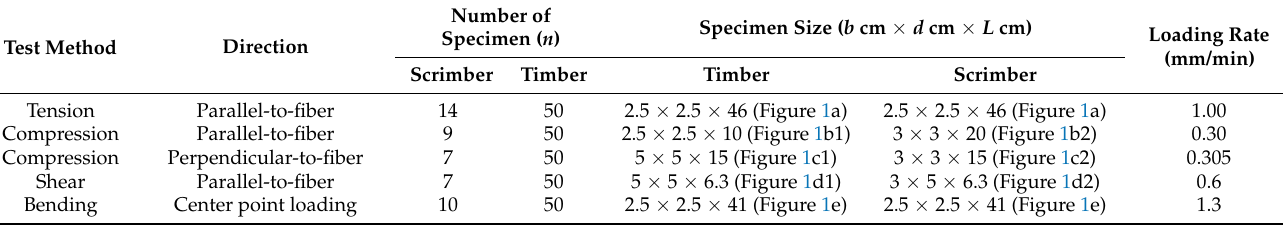
Table 1. Experimental test methods for bamboo scrimber and